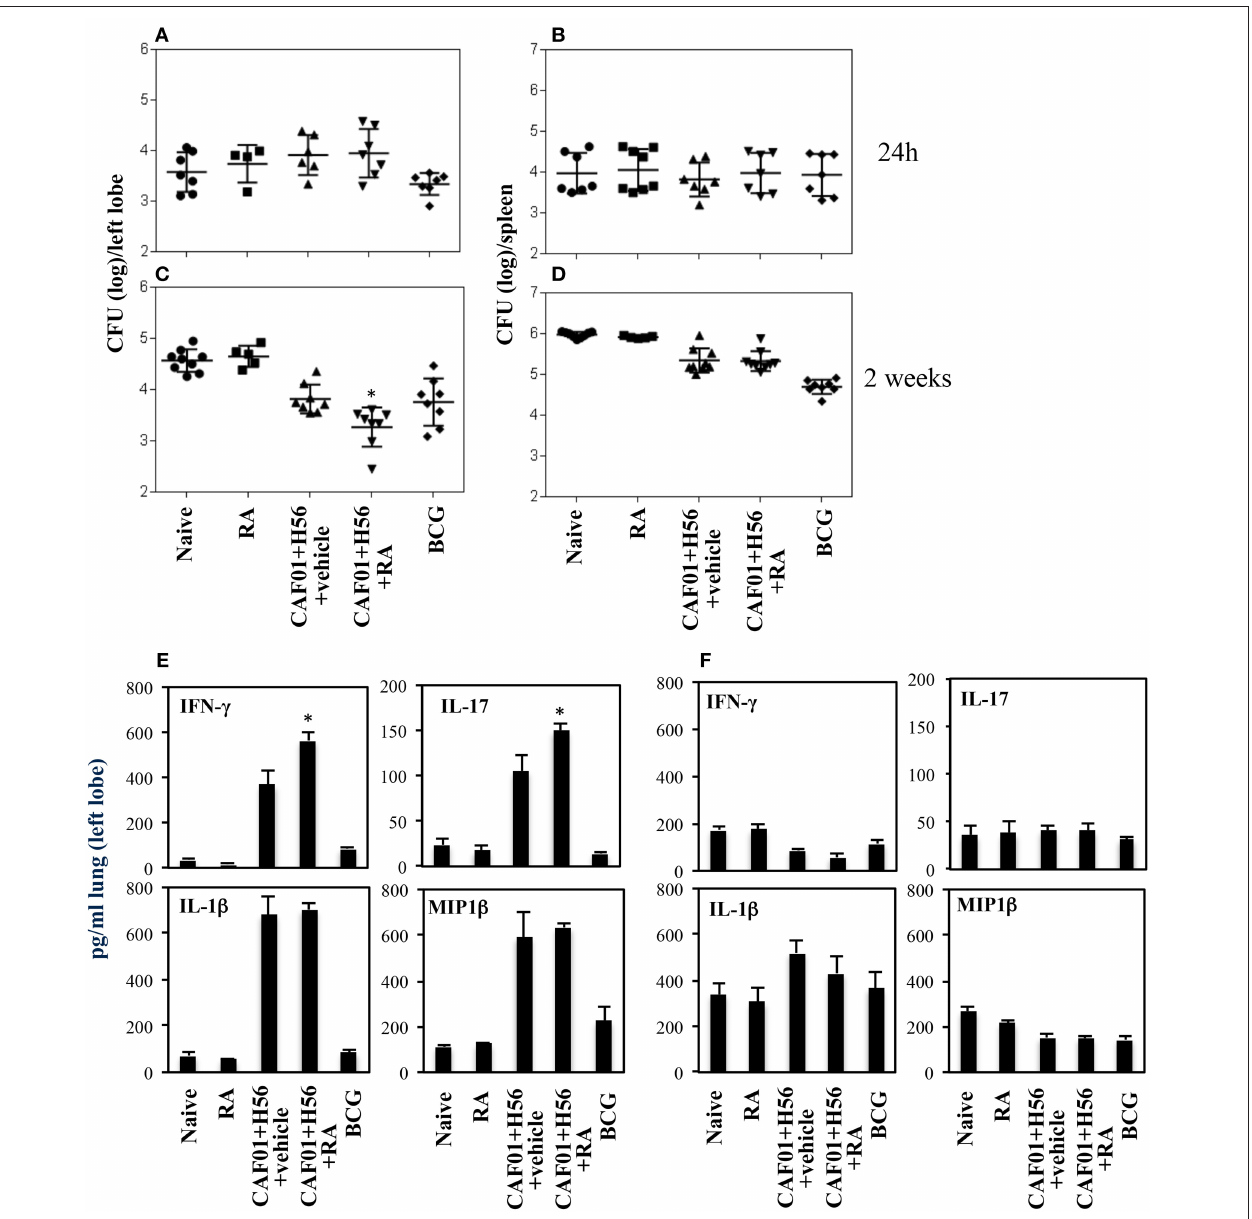
FIGURE 4 | Colony forming unit (CFU) in the lung (A,C) and in the spleen (B,D) of CB6F1 mice. Mice (5–9/group) were treated or untreated with RA (300 µ g/dose, 200 µ g/dose and 100 µ g/dose) or its vehicle, parenterally immunized with H56 (0.5 µ g/dose) and CAF01 (125 µ g/dose) and infected with Mtb (10 5 CFU) 1 month after last immunization. Colony forming units were enumerated 24h and 14 days in the lung (A,C) and in the spleen (B,D) after challenge. Results are expressed in log 10 of the number of CFU/ml. Bars indicate SEM and stars (*) indicate that the differences between the group treated with RA and its vehicle are significant ( p < 0.05). Pro-inflammatory cytokine production in the lungs of CB6F1 mice 24h after Mtb infection. IFN γ , IL-17, IL-1 β and MIP1 β levels were analyzed by ELISA assay in the lung homogenates 24h (E) and 14 days (F) after infection with Mtb in CB6F1 mice treated or untreated with RA or its vehicle and immunized with H56 (0.5 µ g/dose) and CAF01 (125 µ g/dose). One rapresentative experiment is shown of three performed.